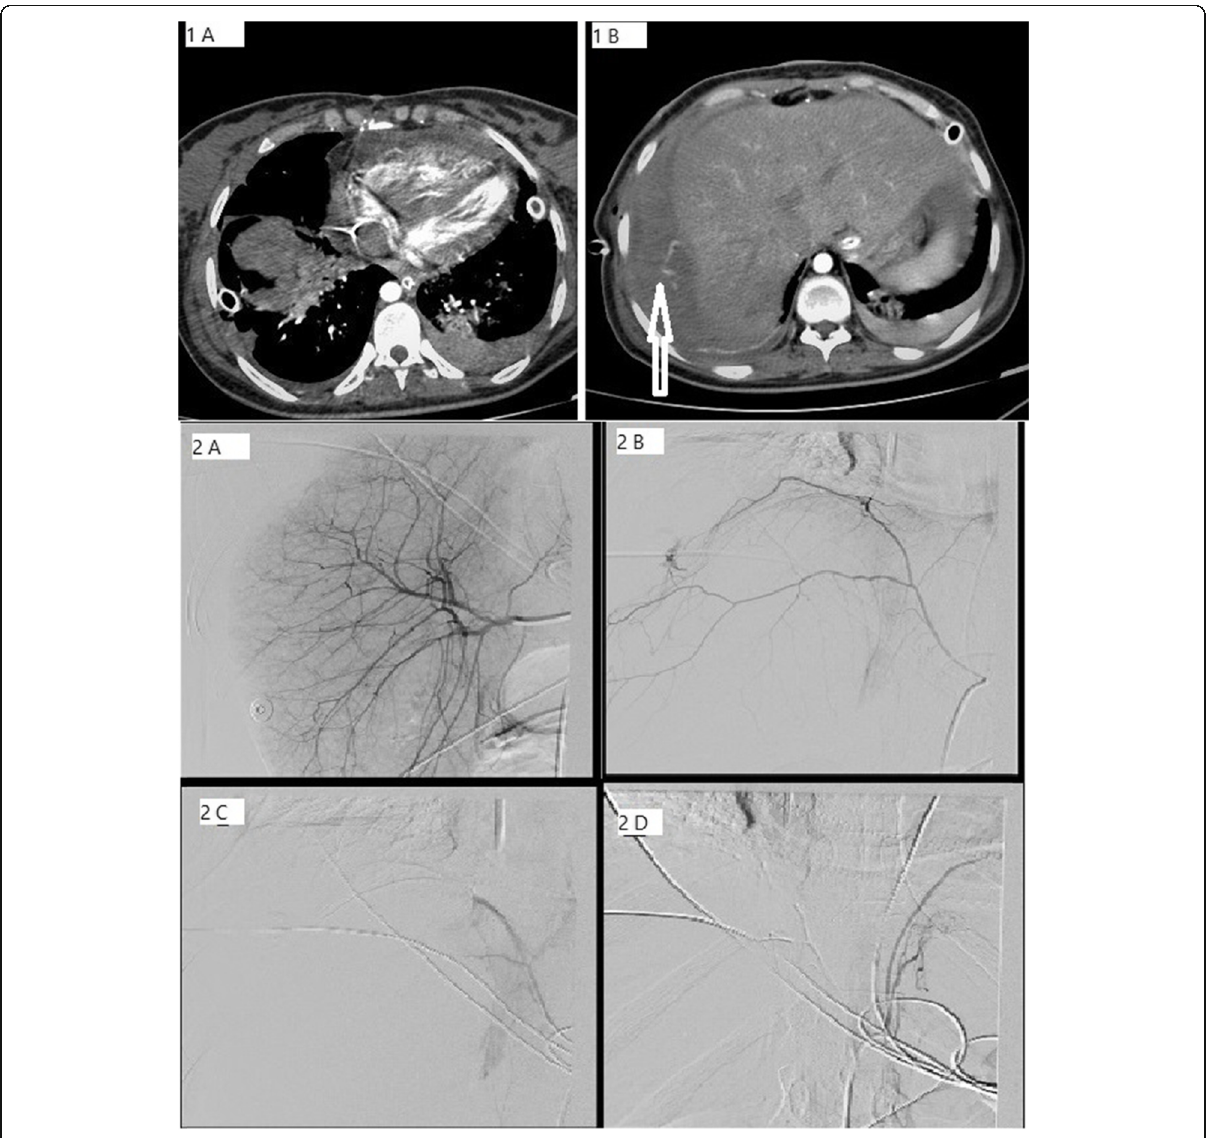
Fig. 1 1A , 1B Axial contrast-enhanced CT — chest and abdomen (arterial phase). 1A Evidence of right lower lung lobe consolidation and left sided pleural effusion. 1B Evidence of active contrast extravasation (white arrow) within high density right subphrenic hematoma. 2A Selective catheter hepatic angiogram revealed no evidence of contrast extravasation. 2B Selective right inferior phrenic artery angiogram revealed evidence of contrast extravasation form the lateral branch of the RIPA. 2C Micro-catheter super selective embolization with small PVA particles of the RIPA bleeding branch with disappearance of the extravasation. 2D further embolization of the RIPA main trunk using N-Butyl